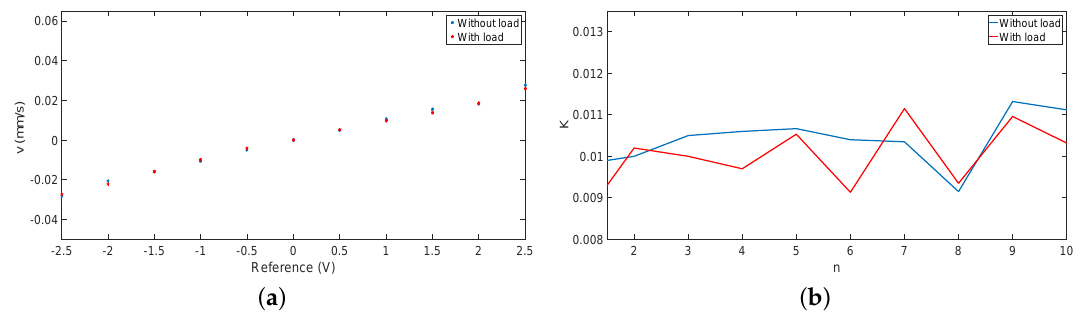
Figure 15. ( a ) relation between the control signal and the velocity; ( b ) estimation of the parameter K of the transfer function